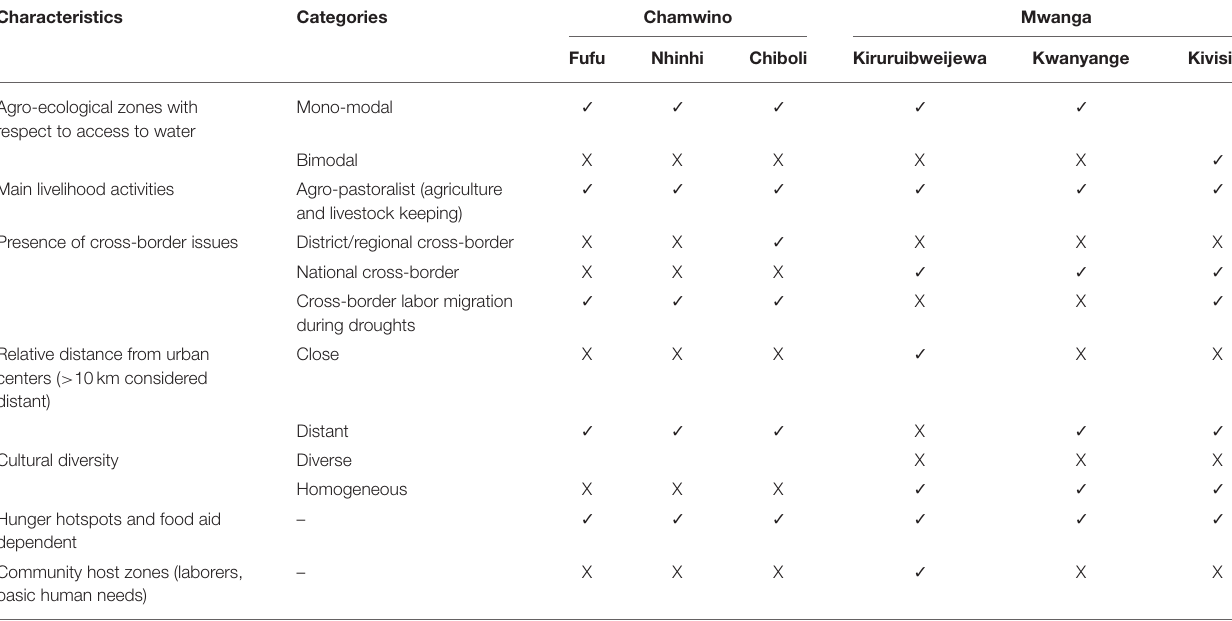
TABLE 1 | Socio-physical characteristics of the study